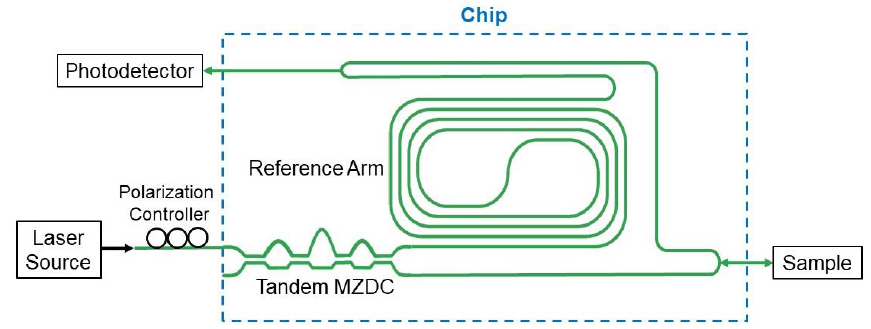
Figure 11. Optical coupler-based OCT interferometer.